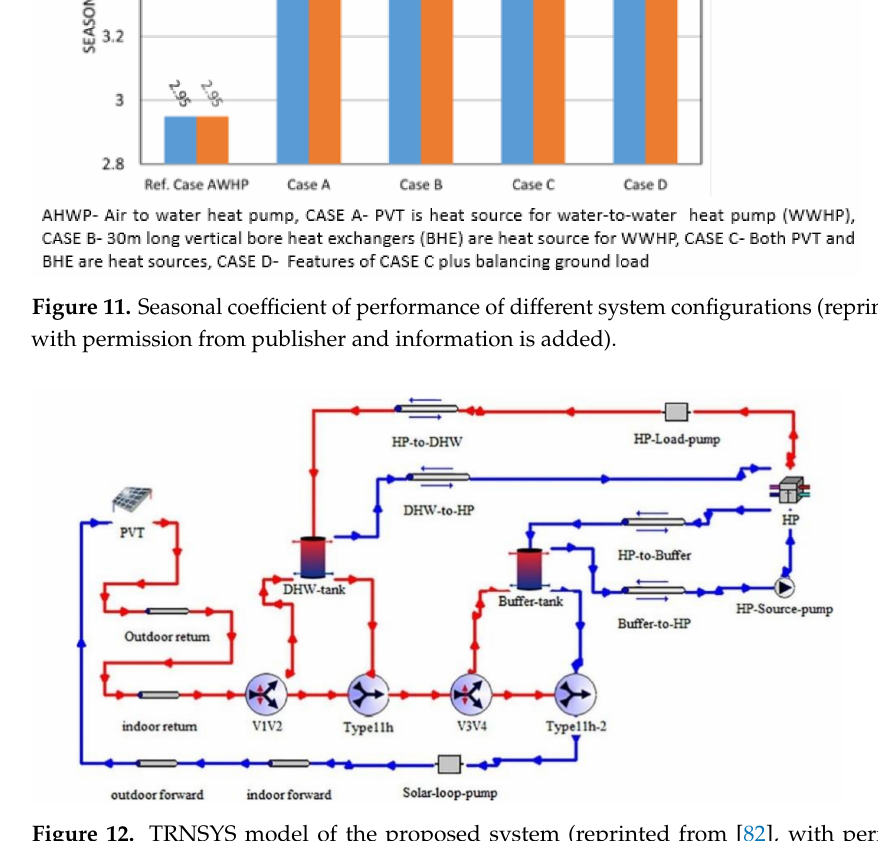
Figure 12. TRNSYS model of the proposed system (reprinted from [82], with permission from